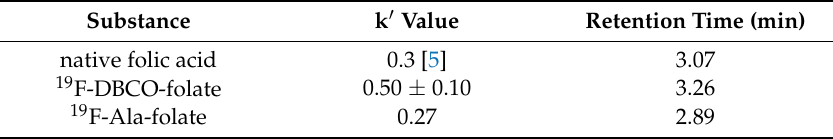
Table 2. k (cid:48) values at pH 2 via reversed-phase